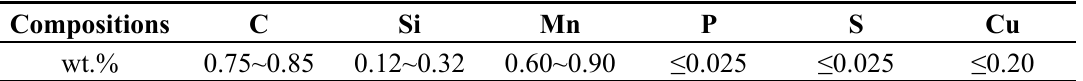
Table 1. Chemical compositions (wt.%) of steel wires.